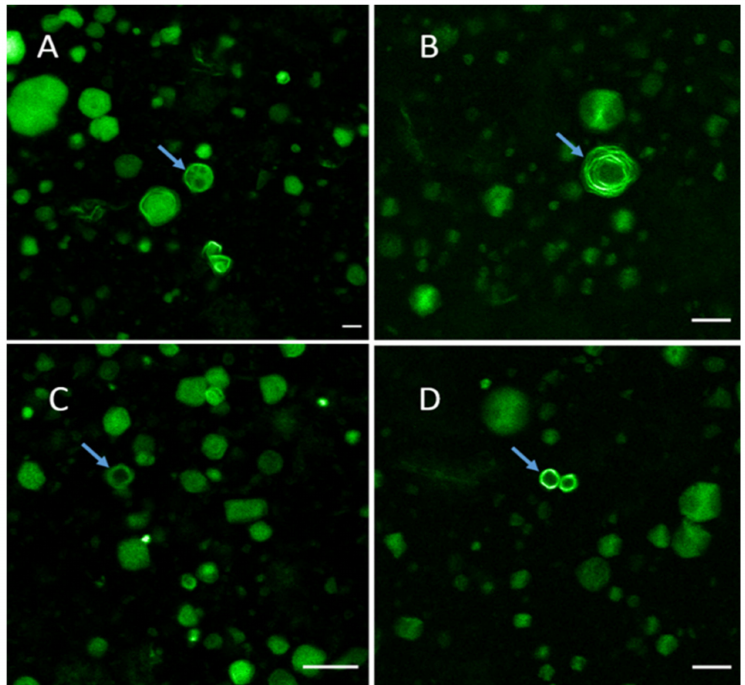
Figure 5. Fluorescence micrographs revealing the various types and internal structures of the BBR-loaded liposomes (before extrusion) generated by the thin-film hydration method (FH12): ( A ) Multivesicular vesicles (MVV); ( B ) Multilamellar vesicles (MLV); and ( C , D ) unilamellar vesicles (UV). Scale bars = 10 µ m.